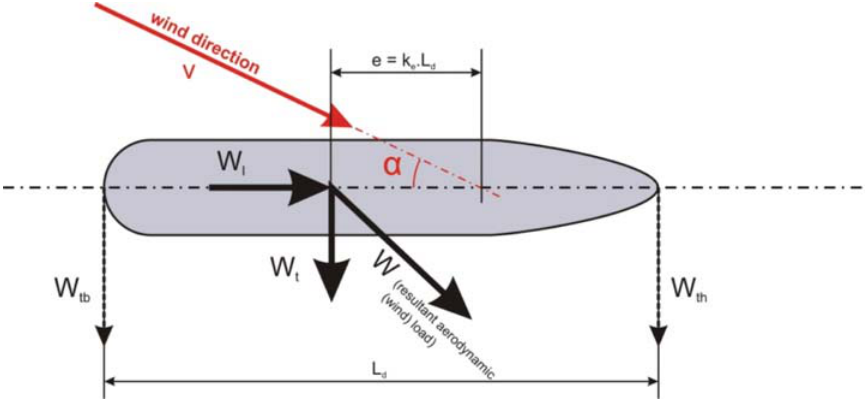
Fig. 11. Aerodynamic loads on ships (Recommendations of the Committee … 2004)